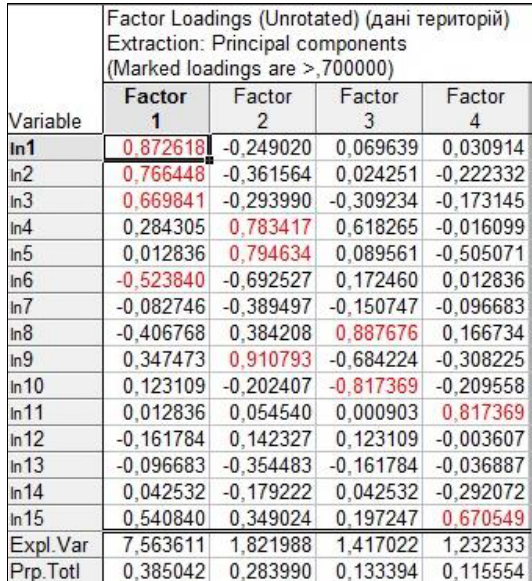
Table 3: Results of the factor analysis of social and economic development of rural areas (STATISTICA program listing)